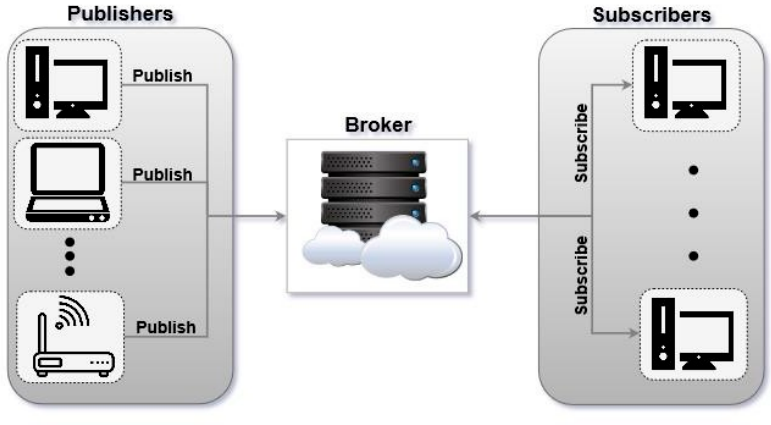
Figure 3. Publish/Subscribe pattern followed by the Message Queue Telemetry Transport (MQTT)